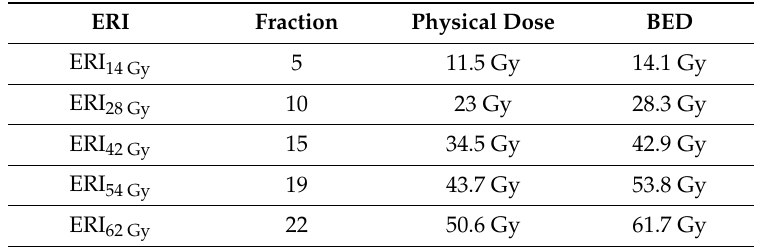
Table 2. Analyzed fractions and corresponding physical and biological biologically e ff ective doses (BED) values, considering an α / β equal to 10 Gy for the tumor.